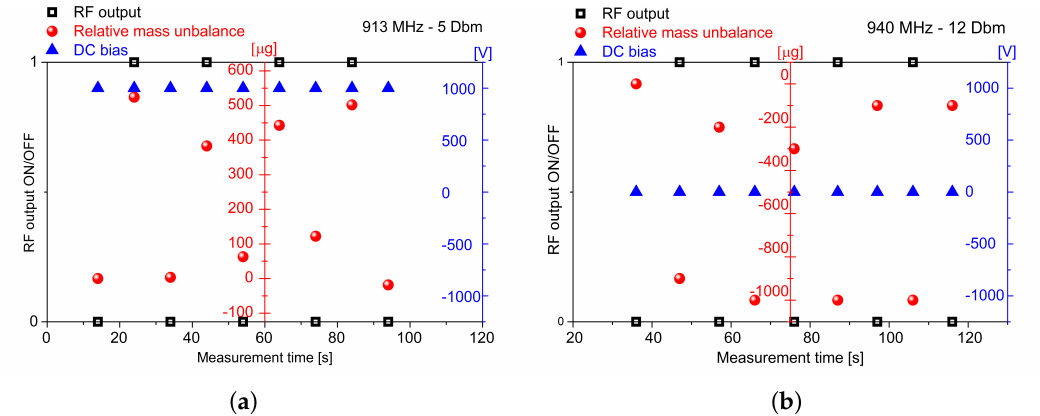
Figure 8. Outcomes relative to two typical experiments performed while applying the RF field and a DC bias. The RF source is switched on and off periodically approximately every 10 seconds of acquisition (black open squares: ‘1’ represents the device on, ‘0’ represents the device off), at 913 MHz at the power of 5 Dbm (panel a ), and 940 MHz at the power of 12 Dbm (panel b ). The DC bias is set at a fixed value (blue triangles). The balance readings are converted into a relative variation scale by taking the initial value (red circles) as zero and eventually removing the small linear drift that can sometimes be found, presumably due to heating/cooling phenomena during the day. The measure in ( a ) was performed positioning the EMT as shown in Figure 2, whereas the one in ( b ) was performed by reversing the